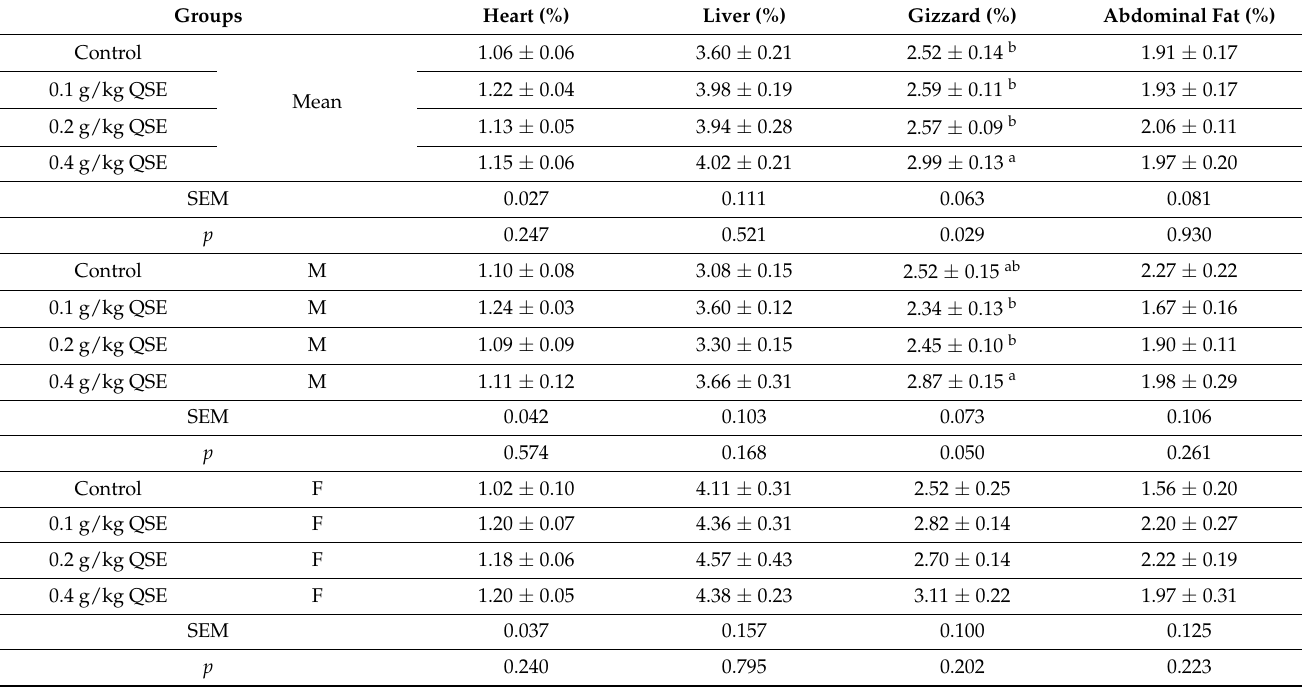
Table 8. Edible internal organs and abdominal fat